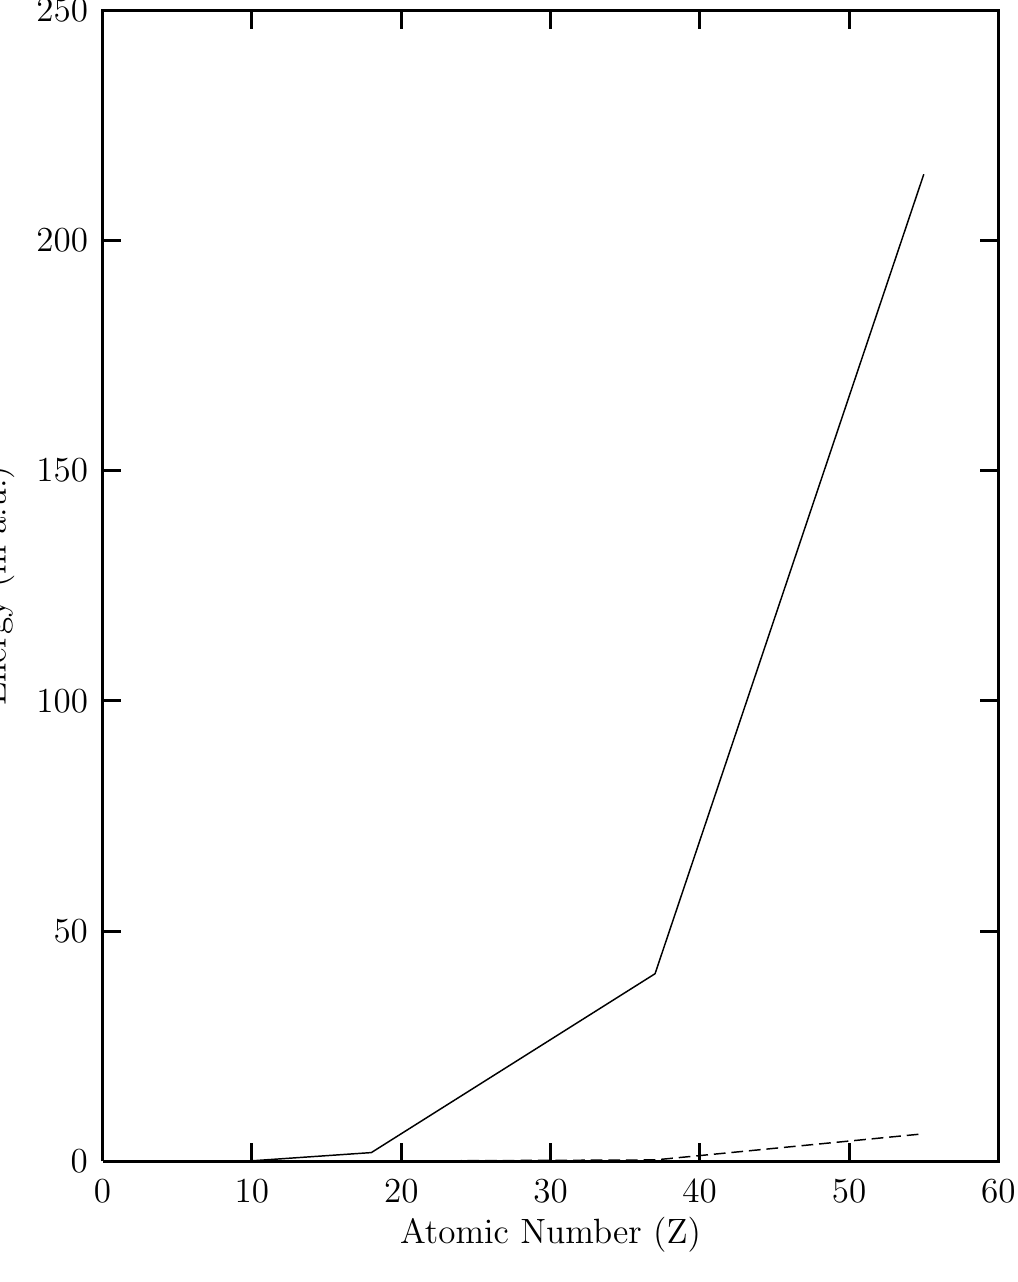
| (dotted line) versus the atomic − E RESC gr gr